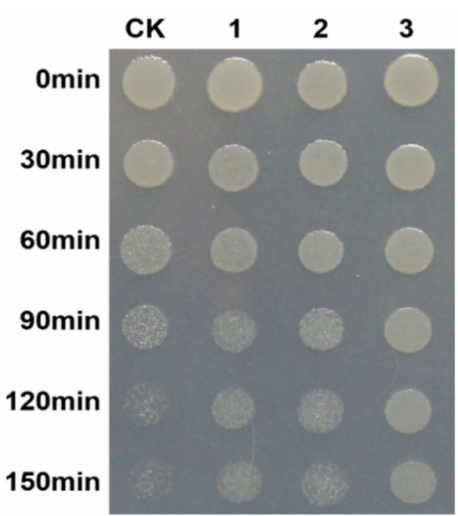
Figure 9. Growth of colony on the plate after heat stress. CK: control group pET32a (+), 1: pET32a (+)-WcHSP100-1, 2: pET32a (+)-WcHSP90-1, 3: pET32a